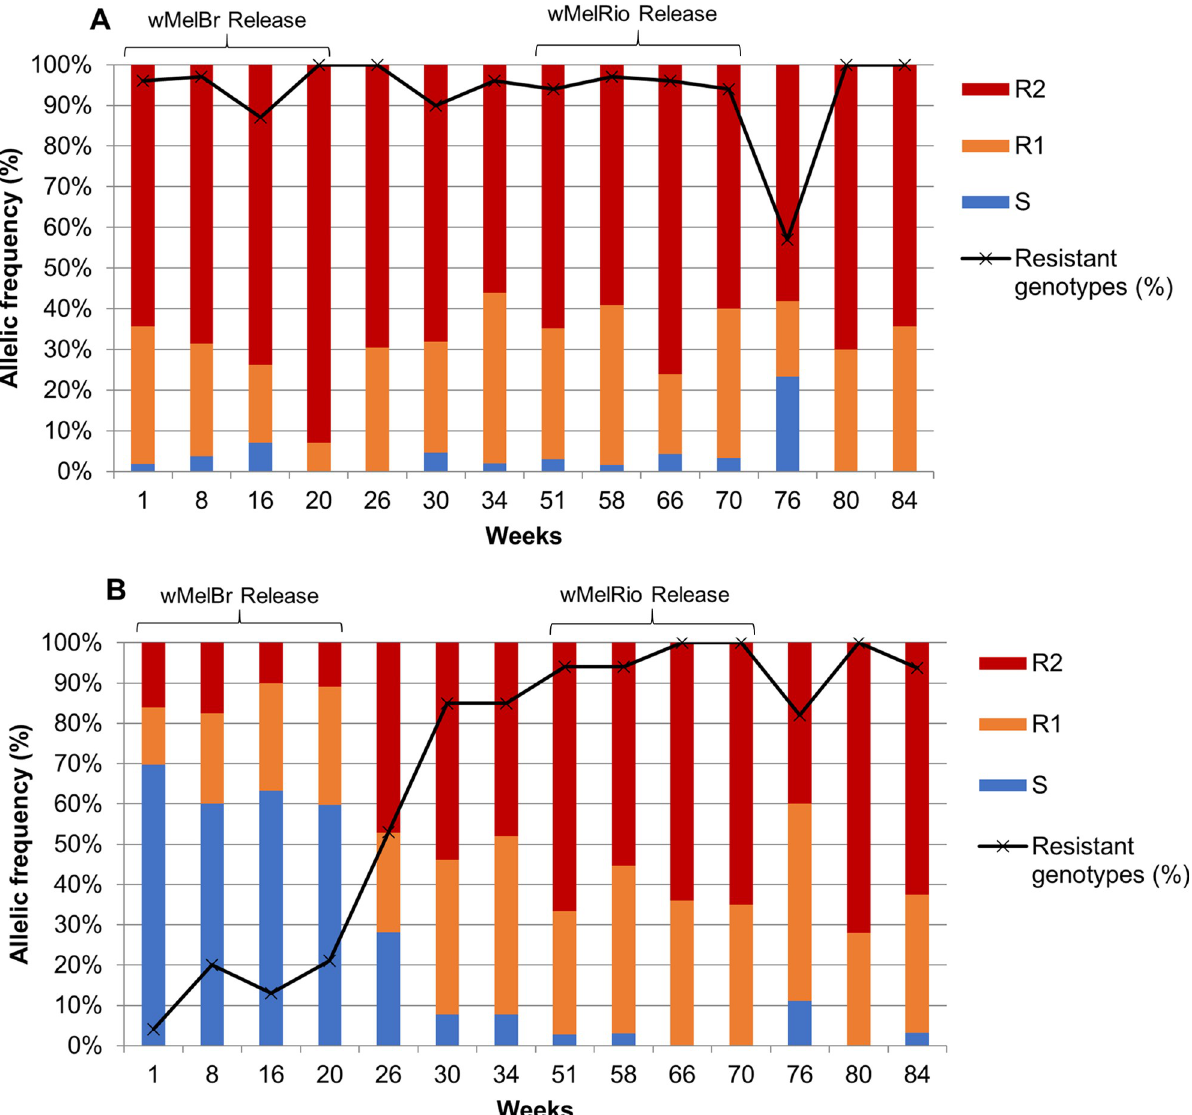
Fig 3. Frequency of kdr alleles during Wolbachia releases in Tubiacanga. At least 60 mosquitoes were analyzed per time point. Field-caught mosquitoes (A) without Wolbachia , and (B) infected with Wolbachia . In blue Na V S (1016 Val + + 1534 Phe + ), in orange Na V R1 (1016 Val + + 1534 Cys kdr ) and in red Na V R2 (1016 Ile kdr + 1534 Cys kdr